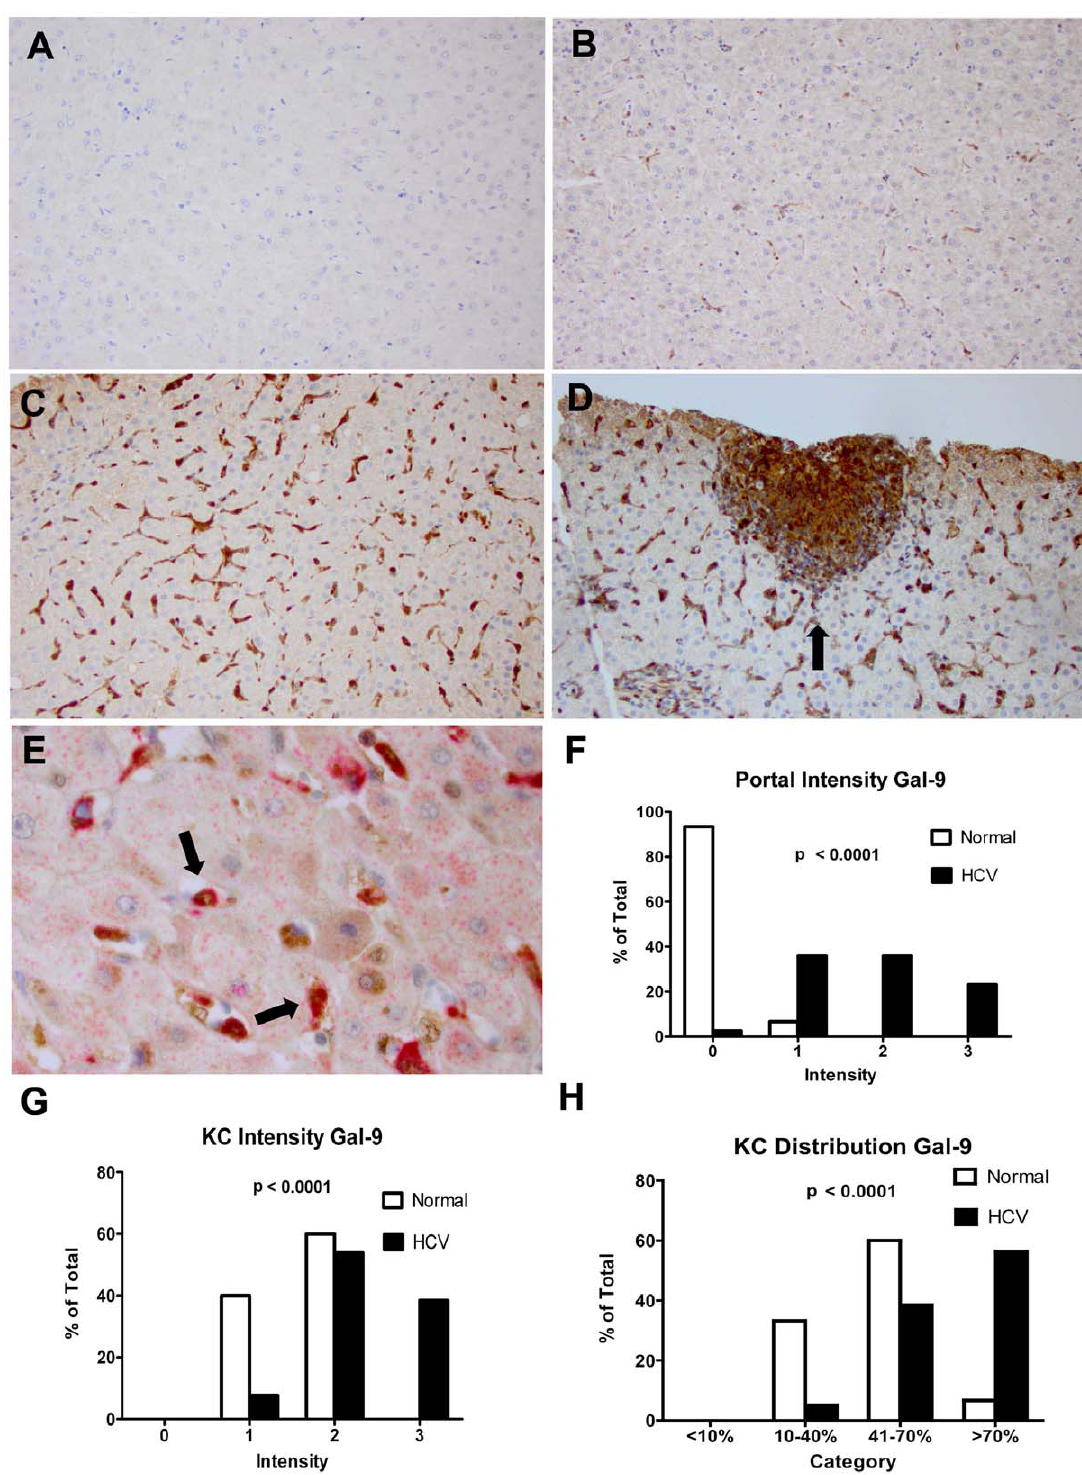
Figure 2. HCV patients have increased Galectin-9 in Kupffer cells and periportal areas. Immunohistochemistry of paraffin embedded samples (see Methods for details) was used to analyze 39 samples from HCV-infected patients and 15 normal subjects for galectin-9 staining. Staining for CD68 was used to identify Kupffer cells. The analyzing pathologist (M.S.) was blinded to patient identity and medical history. ( A ) Negative control with secondary antibody only, 20 6 magnification. ( B ) Galectin-9 staining in normal liver (brown) 20 6 ; ( C ) Galectin-9 staining in a HCV patient 20 6 , ( D ) Periportal galectin-9 staining in HCV patient, 200 6 . ( E ) Co-localization of galectin-9 (brown) and CD68 (red) 600 6 . ( F–H ) Intensity of galectin-9 was scored from 0 to 3, and frequency was scored 0 ( , 10%), 1 (10–40%), 2 (40–70%), 3 ( . 70%). Distribution of scores by category expressed as a percent of the total patients comparing normal patients to patients with HCV. P-values calculated by the Chi-square test for trend.